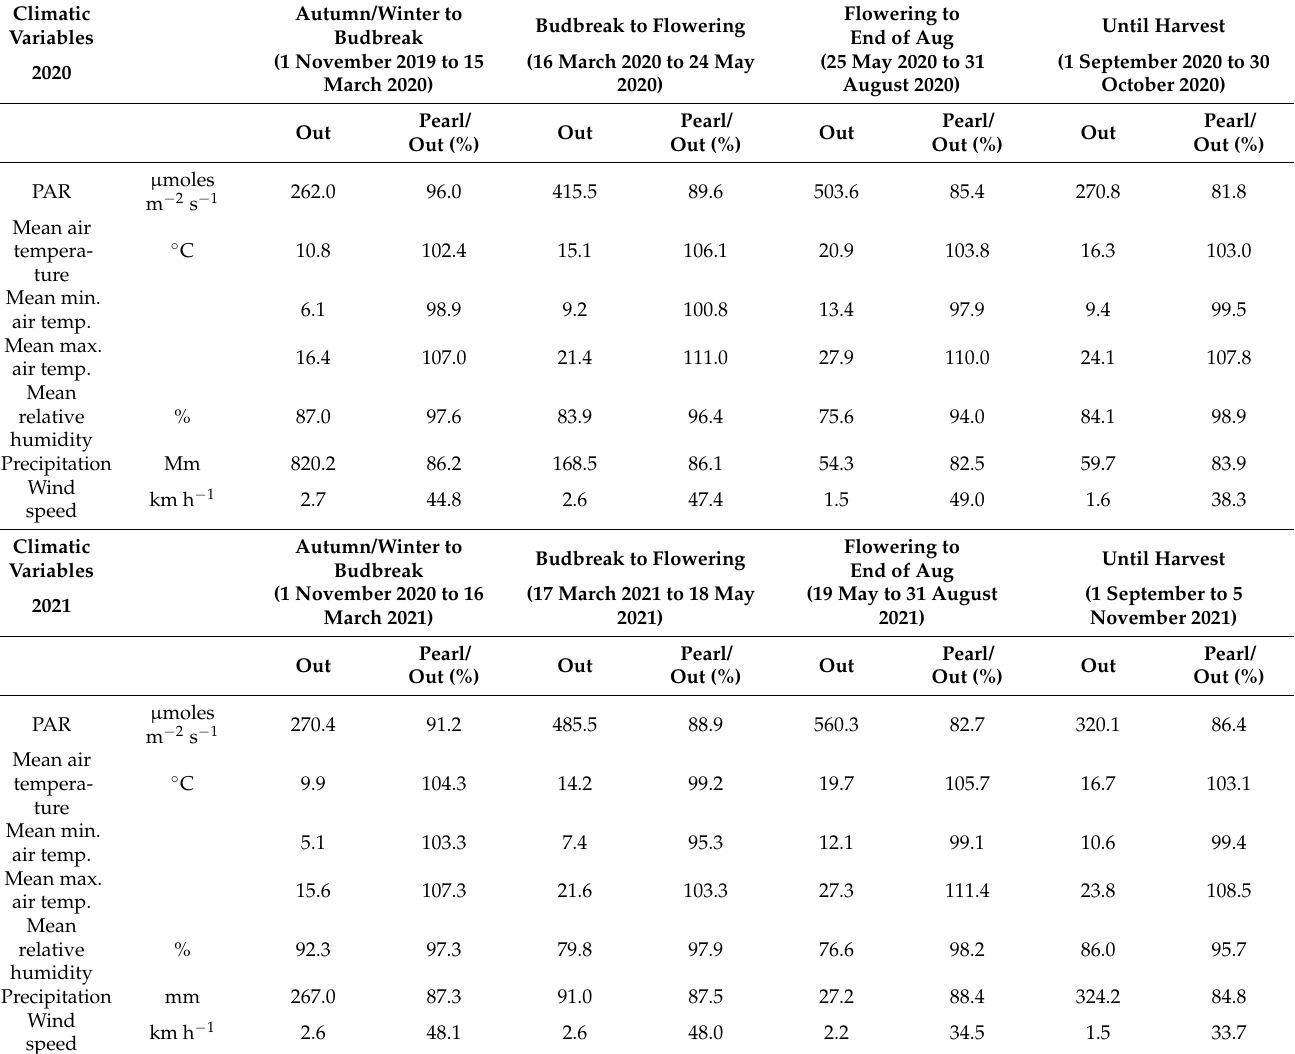
Table 3. Mean values of climatic variables outside (Out) and the ratio under the photo-selective pearl net (Pearl) and outside conditions (%) throughout crop growth and development in 2020 and